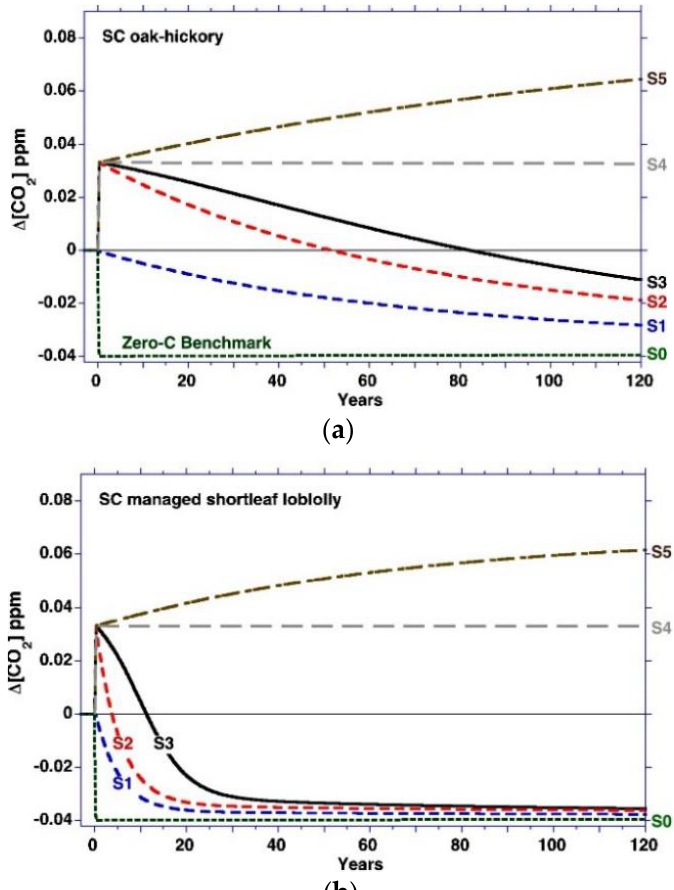
Figure 2. The effects of displacing coal with wood on changes in atmospheric CO 2 concentration. ( a ) Displacing coal with wood cut from south-central oak-hickory forest; ( b ) displacing coal with wood cut from south-central managed shortleaf loblolly. Figure taken from [44].